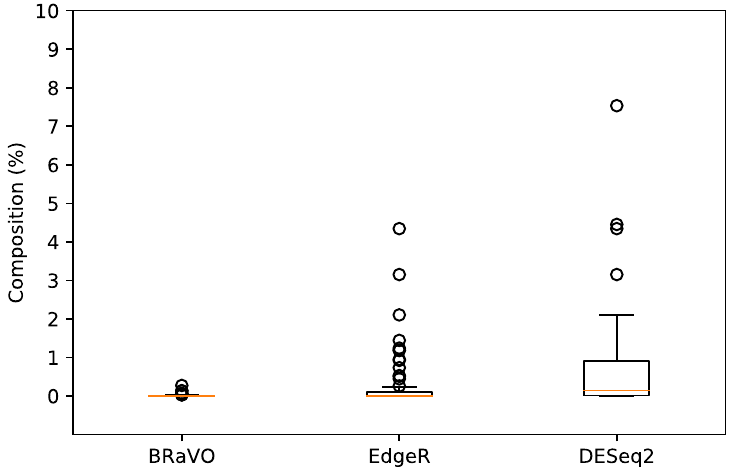
Figure 2. Composition and distribution of outliers. This figure shows the compositional percentages of taxonomic abundance for outliers detected by BRaVO, EdgeR, and DESeq2. Horizontal lines inside these box plots are their median values. Lower and upper box limits are the 25th and 75th percentiles in their distribution. Less than 25th percentile and more than 75th percentile are shown as unfilled circles. The compositional percentages of outliers detected by BRaVO, EdgeR, and DESeq2 were in the range (min-max) of 0.00014–0.27178%, 0–4.34274%, and 0.00014–7.53432%,